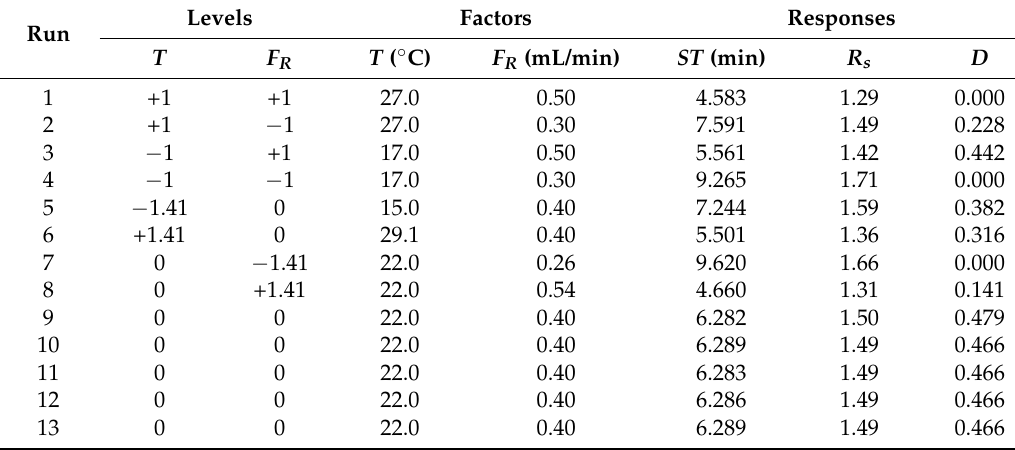
Table 1. Experimental variables, levels, design matrix and responses for the central composite design 1 .